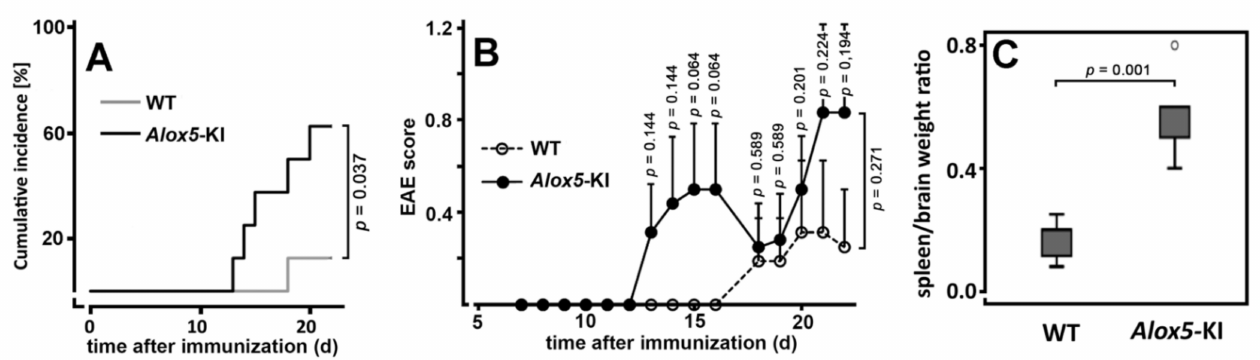
Figure 5. Comparison of Alox5 -KI and wildtype mice in the EAE inflammation model. Alox5 -KI mice and wildtype controls ( n = 8 in each group) were taken through the experimental protocol (see Materials and Methods). The clinical EAE scores were determined at the time points indicated. At the end of the experiment the animals were sacrificed at day 22 of the experimental protocol. Data were statistically evaluated using Mann-Whitney U-Test and the mixed ANOVA approach was used to compare the EAE score kinetics of the two genotypes over time. Cumulative incidence was statistically analyzed by Log-Rank test. ( A ) Onset of disease as indicated by the first appearance of neurological symptoms. ( B ) EAE score kinetics. Data are means ± SEM. ( C ) Relative spleen weight vs. brain weight ratios of the two genotypes ( n = 8 in each experimental group) at the end of the experimental protocol (day